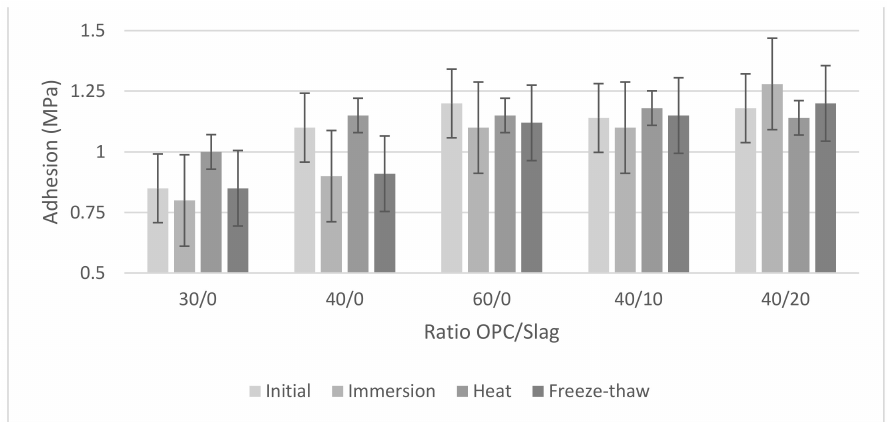
Figure 3. Tensile adhesion according to EN 12004 for a tile adhesive as a function of OPC and GGBS (slag) content, keeping rubber dosage constant.